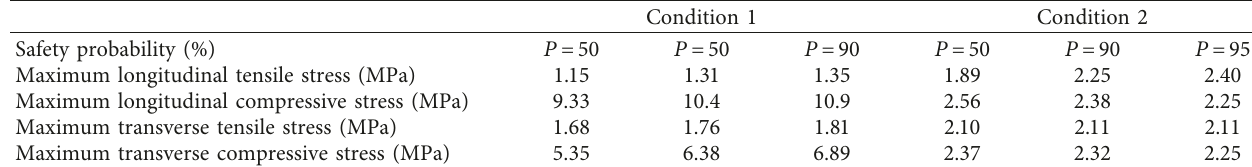
Table 7: Maximum stress of the self-compacting concrete layer. Condition 1